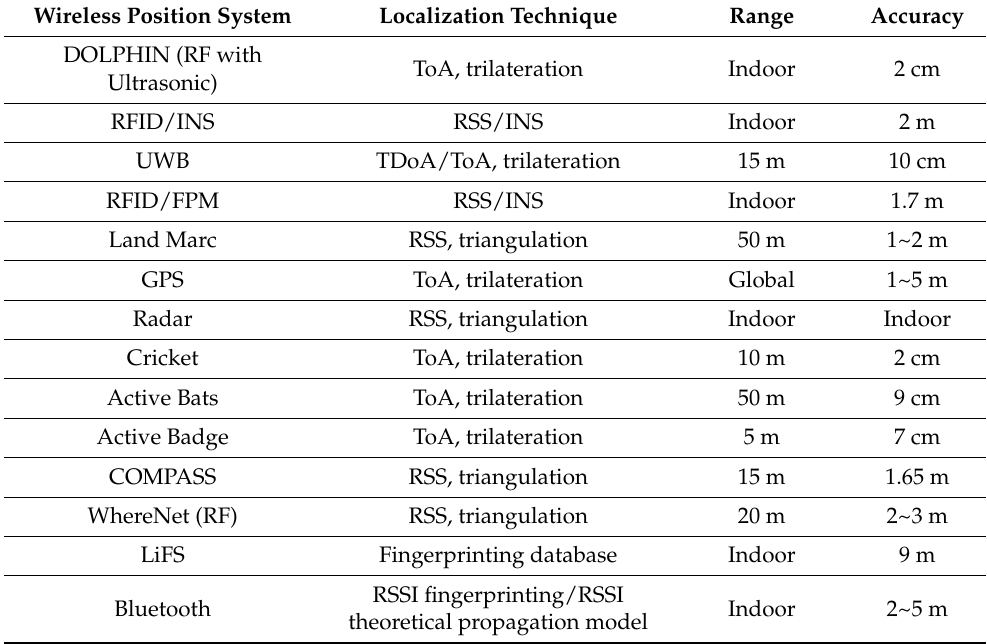
Table 1. Comparisons of characteristics in various positioning technologies [16].